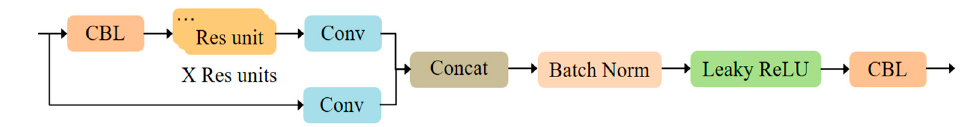
Figure 5. Composition of the CSP1_X block .